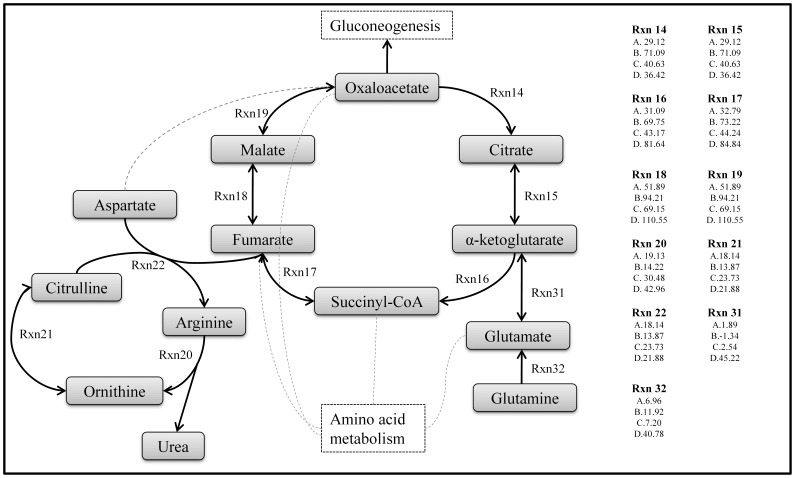
Detailed flux distribution map in the TCA and urea cycles.Thick black lines indicate active (or dominant) reactions. Dashed lines depict reactions not shown in detail. Positive flux values of reversible reactions indicate a net oxaloacetate production from citrate (for TCA cycle reactions), arginine and urea production from ornithine and citrulline (for urea cycle), and α-ketoglutarate production from glutamate. Fluxes of irreversible reactions should be equal or greater than zero. Directions of reactions are given in Table 1. Flux units are µmol/g liver/h. A: Sham+Fed group; B: Sham+Fasted group; C: Burn+Fed group; D: Burn+Fasted group.